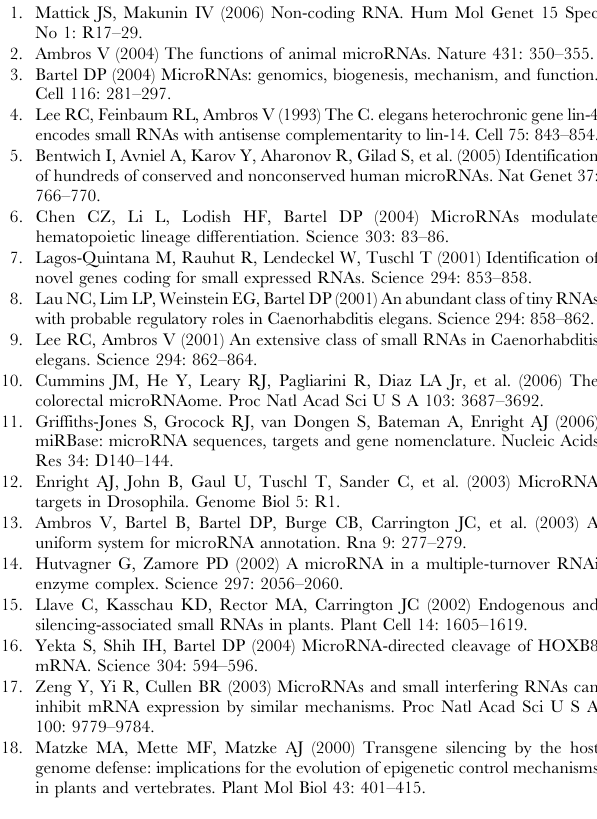
Figure S1 Dendogram showing relationships among tissues from the Novartis Foundation Symatlas microarray dataset. Cancer tissues are indicated with the red bar.